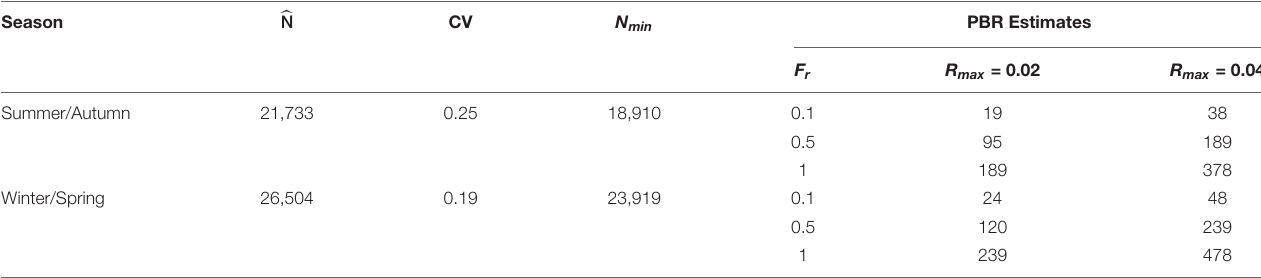
(cid:16) ˆ (cid:17) N , coefficient of variation (CV), 20 th Percentile of abundance ( N min ) and the maximum number of common dolphins ( Delphinus TABLE 4 | Estimates of abundance delphis ) that may be removed sustainably (Potential Biological Removal, PBR) from central South Australia under different recovery factors ( F r ) and maximum population growth rates ( R max